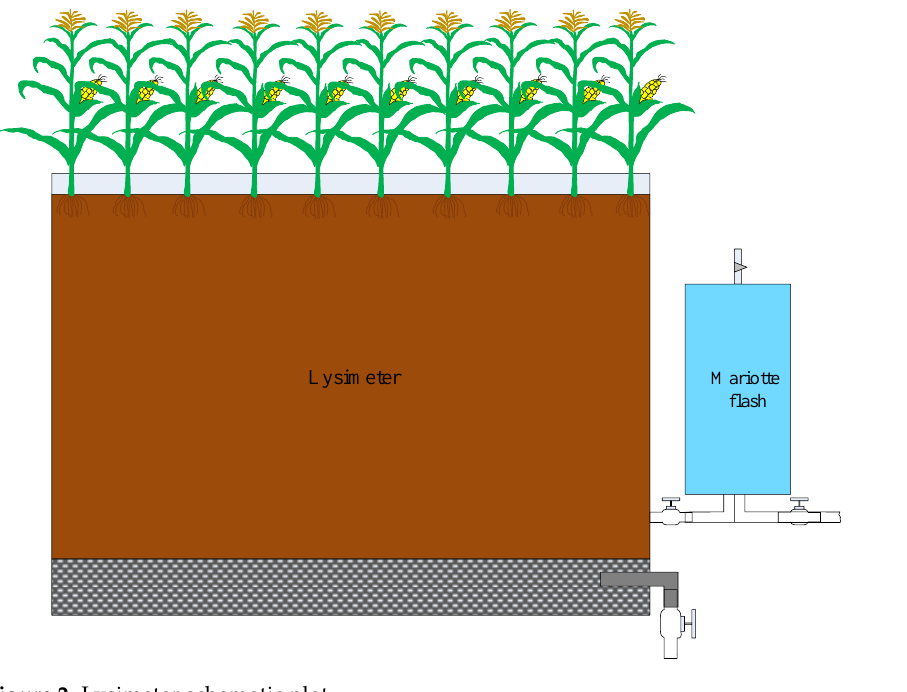
Figure 1. Field experiment of long-term monitoring lysimeter in Xinxiang Agricultural Water and Soil Environment Field Scientific Observation and Experiment Station, Chinese Academy of Agri- cultural Sciences.